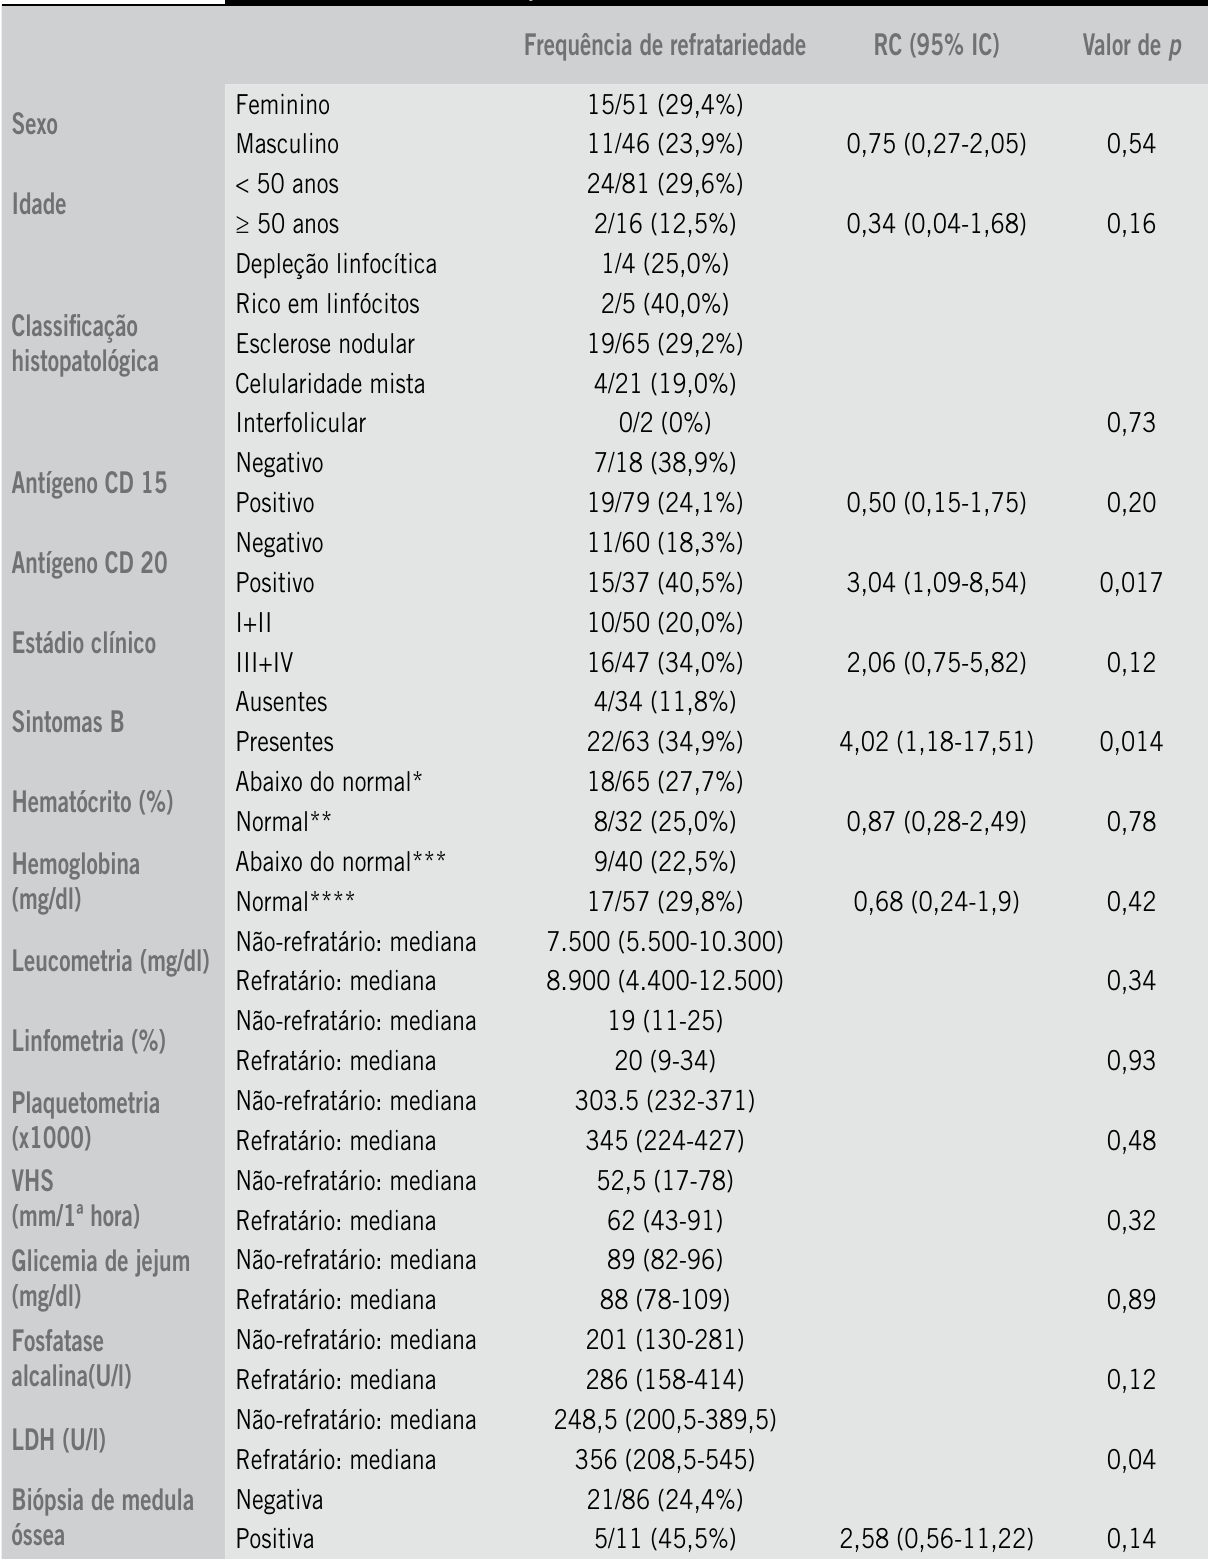
Variáveis analisadas quanto à relação de prognóstico na refratariedade do LHc ao tratamento inicial com o esquema ABVD (análise